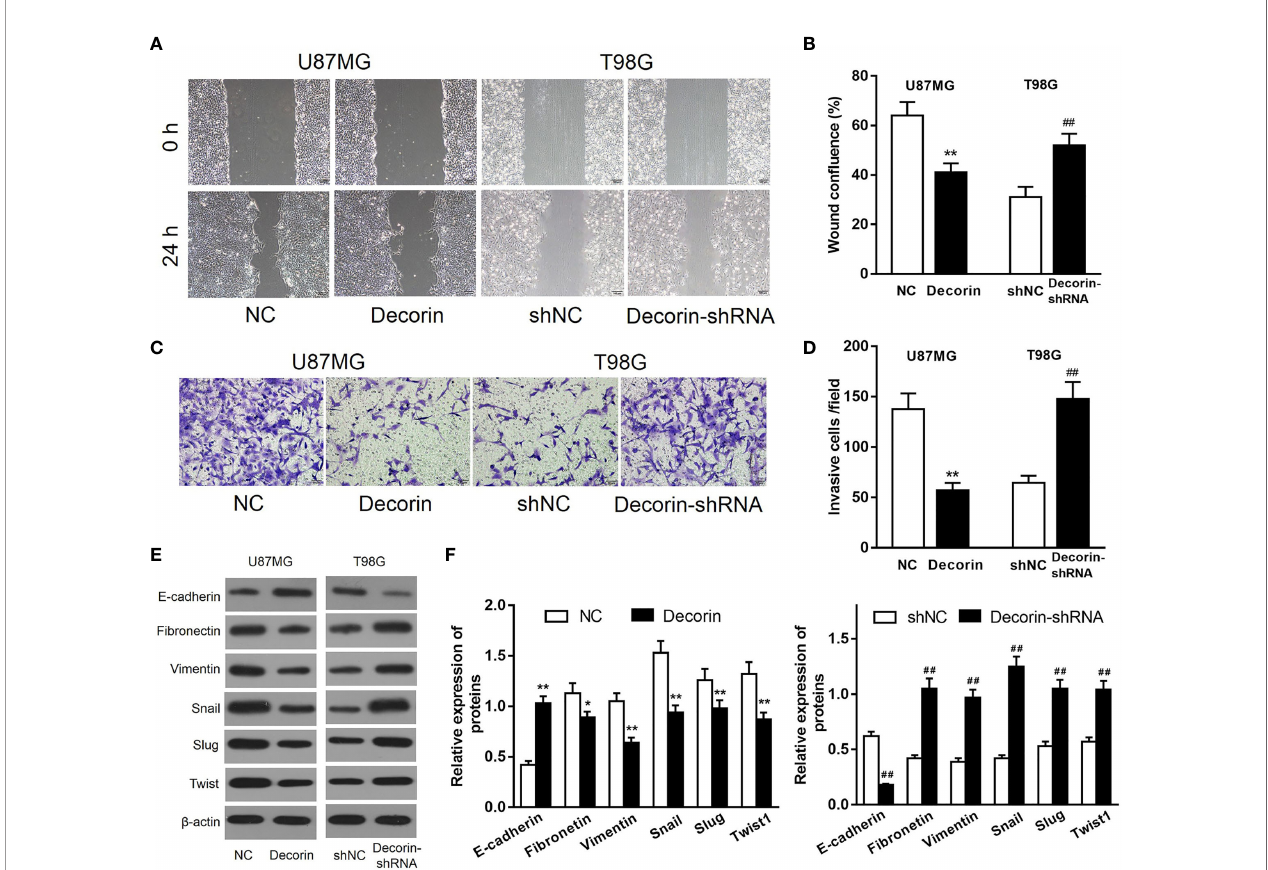
FIGURE 2 | Decorin inhibits cell migration, invasion and ameliorates EMT phenotype in glioma cell lines. (A) Wound-healing assay of U87MG and T98G cells with decorin overexpression and decorin silencing. Decorin overexpression dramatically decreased the cell migration in U87MG-decorin cells compared with that in U87MG-NC cells. T98G-decorin-shRNA cells showed a signi fi cantly increased cell migration compared to the T98G-shNC cells. (B) Measurement data of cell migration results (means ± S.D. @ of 3 independent experiments). (C) Overexpression of decorin signi fi cantly decreased the number of invasive U87MG cells. However, silencing of decorin signi fi cantly promoted cell invasion in T98G cells. (D) Measurement data of cell invasion results (means ± S.D. @ of 3 independent experiments). (E) Evaluation of the effects of decorin on the EMT phenotype. Western blot results showed that overexpression of decorin signi fi cantly increased the expression of E-cadherin, but suppressed the mesenchymal markers vimentin and fi bronectin, and inhibited the expressions of EMT-related proteins Snail, Slug and Twist. In contrast, decorin-silencing down-regulated the expression of E-cadherin, and up-regulated the mesenchymal markers and EMT-related proteins. (F) Measurement data of Western blot results (means ± S.D. @ of 3 independent experiments). *P < 0.05, **P < 0.01 vs. NC; ## P < 0.01 vs.